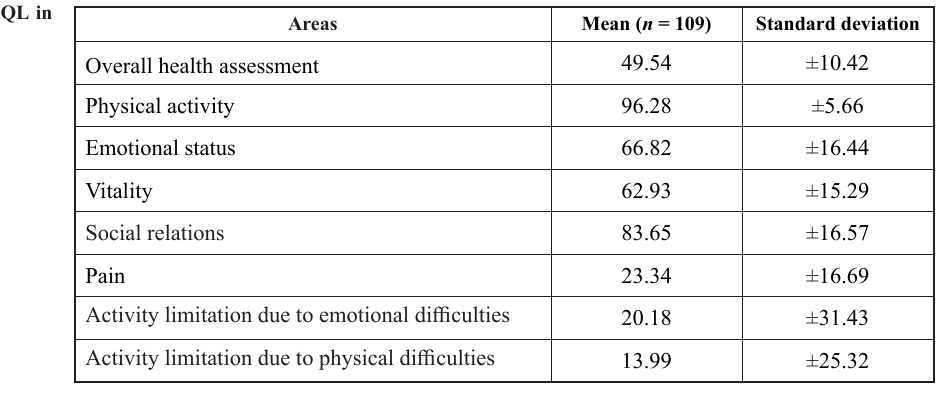
Table 2. Evaluation of HRQL in competitive and recreational athletes